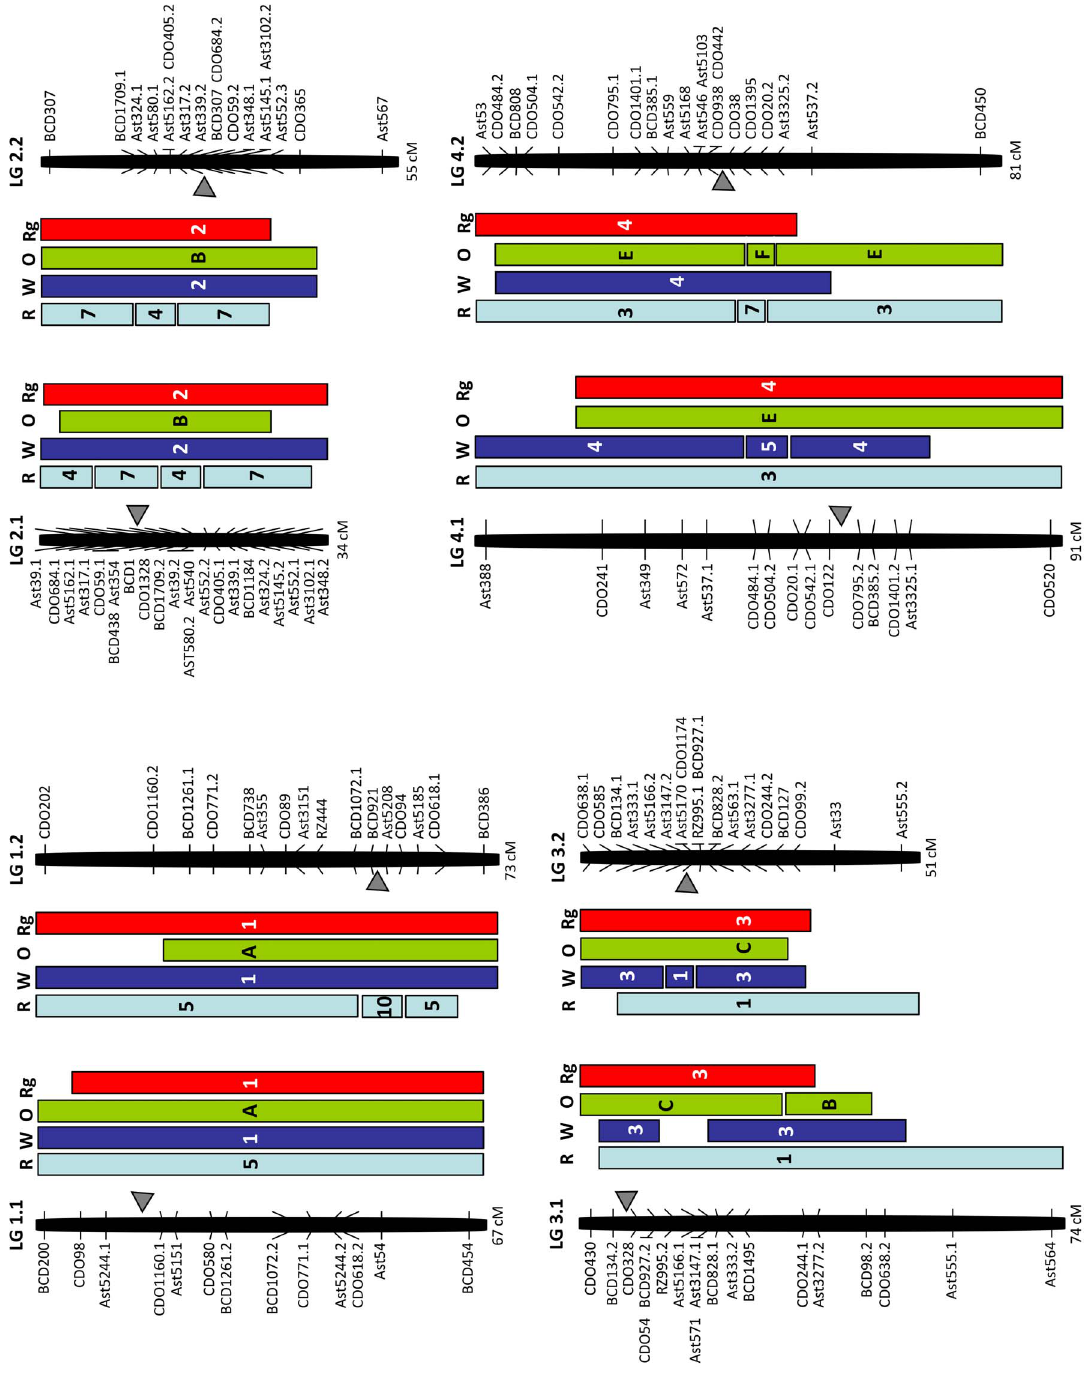
Figure 2. Comparative genome relationships on creeping bentgrass linkage groups 1 – 4 relative to rice, the Triticeae, oat, and ryegrass. Comparative genome relationships between creeping bentgrass genetic linkage map and the genetic maps of rice (R), the Triticeae (W), oat (O), and ryegrass (Rg), respectively, represented by a colored box. The markers shown on the right or left side of each linkage group correspond to those mapped in the creeping bentgrass linkage map shown in Figure 1. The number or letter inside the color boxes represents the segments of chromosomes or linkage groups from each of the genomes (R, W, O, Rg) that are syntenic to the bentgrass linkage groups. The arrowheads indicate the deduced location of the centromere in bentgrass from the comparisons with Triticeae chromosomes. The total map distances (cM) are shown on the bottom of each linkage group.